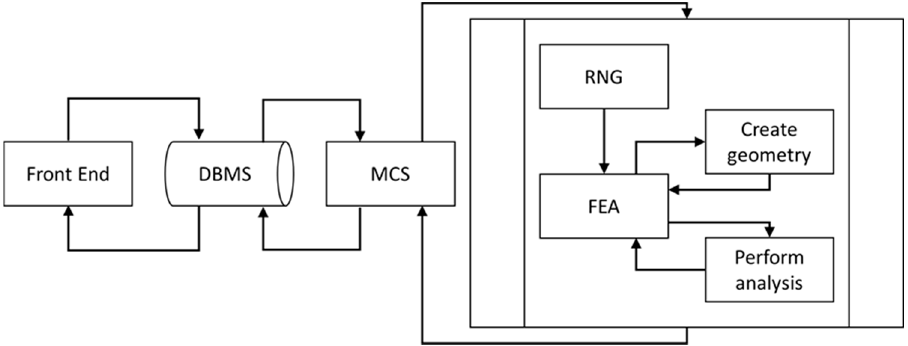
Figure 1. Schematic of the SFEA framework [58].